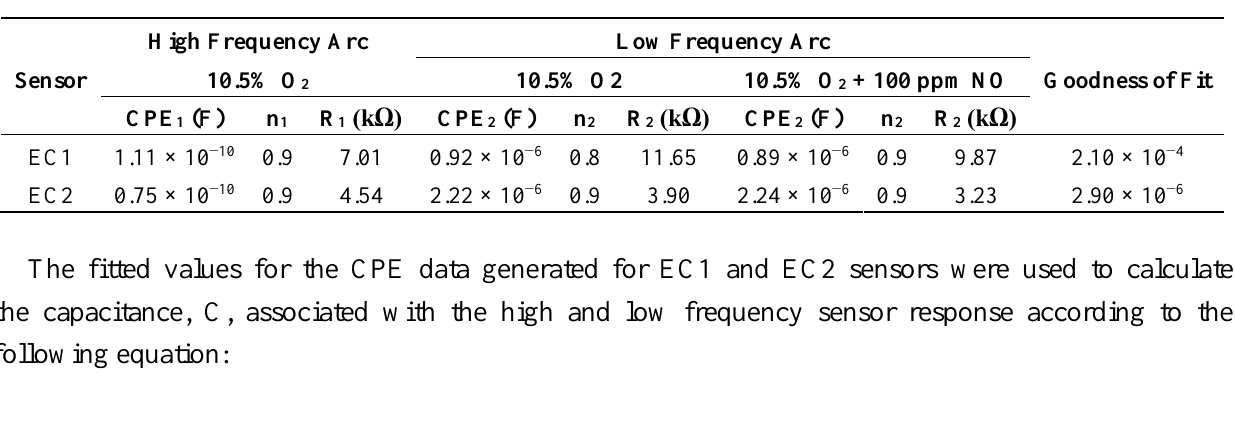
Figure 2. Typical Nyquist plot showing the impedance response of EC1 and EC2 sensors at an operating temperature of 650 °C, in 10.5% O 2 with and without NO present. The equivalent circuit used to model the data is shown in the upper right corner of the plot. The model that fit the data is described by the solid lines. Table 1. Equivalent circuit fitting parameters are shown for sensor impedance data collected at 650